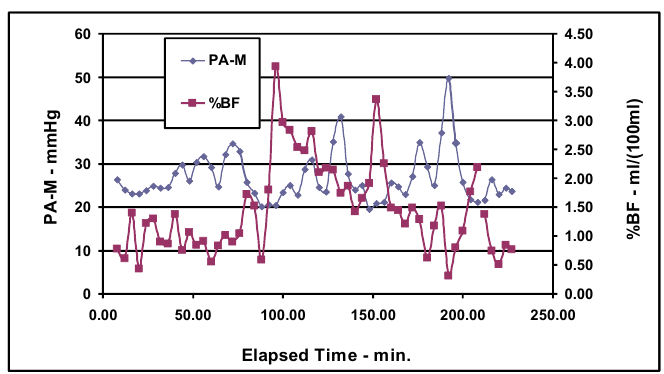
Figure 5. Mean pulmonary arterial pressure (PA-M) and calf percent blood flow (%BF) vs. elapsed time.